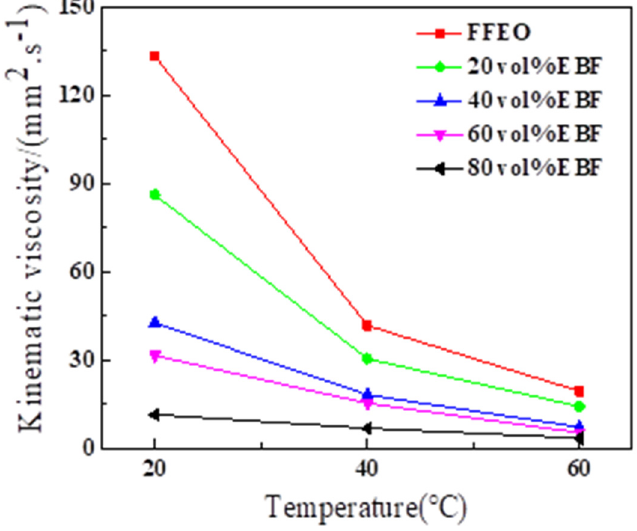
Figure 9. Variations in kinematical viscosity of oil samples as functions of temperature.